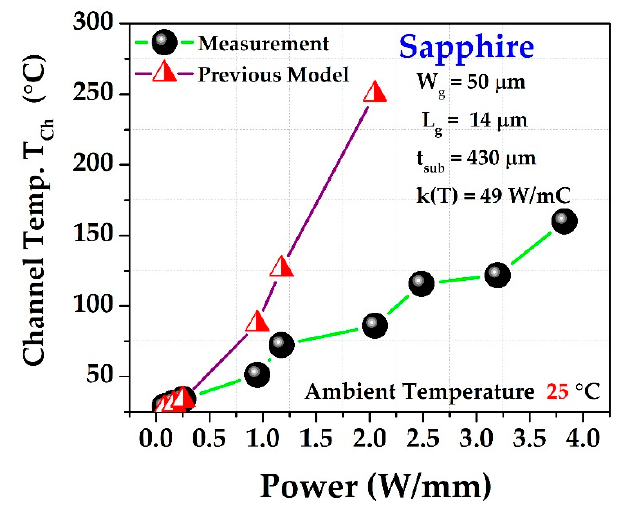
Figure 4. Previous model (marked as half-red triangle) over-estimates T ch , which does not match with the experimental results (black sphere).